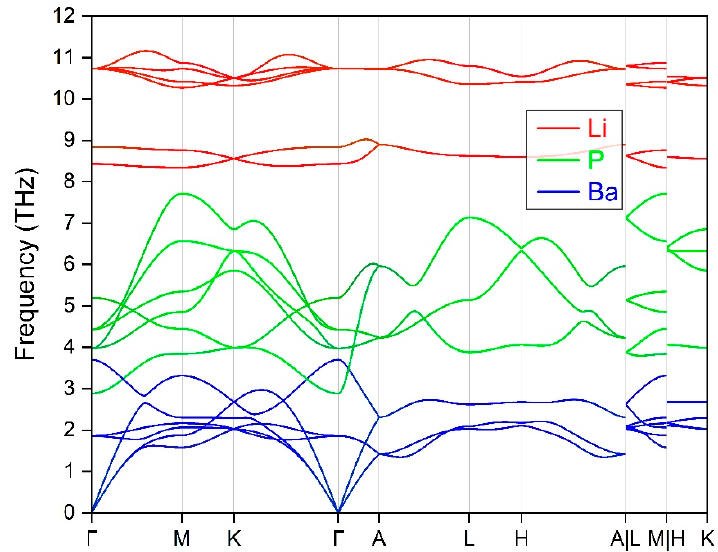
Figure A3. The phono band spectra with element contribution decomposition as overlaid by differ- ent color weights: red color for Li, green color for P and blue color for Ba.